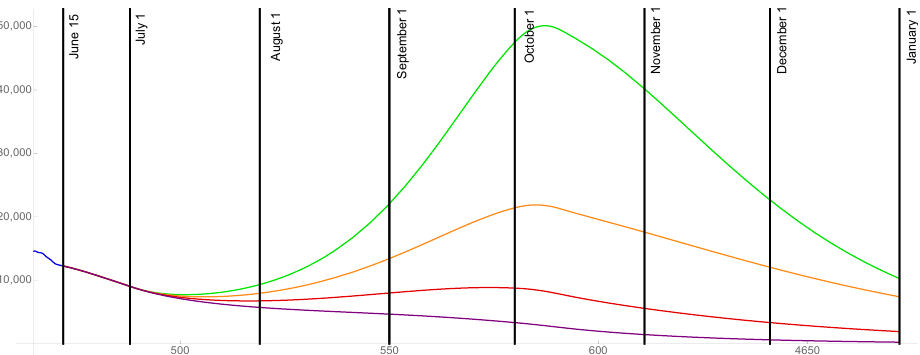
Figure 11. Model outcomes for the daily reported cases DR ( t ) , for the level of social distancing resumption ω = 0.03 (green), ω = 0.025 (orange), ω = 0.02 (red), ω = 0.015